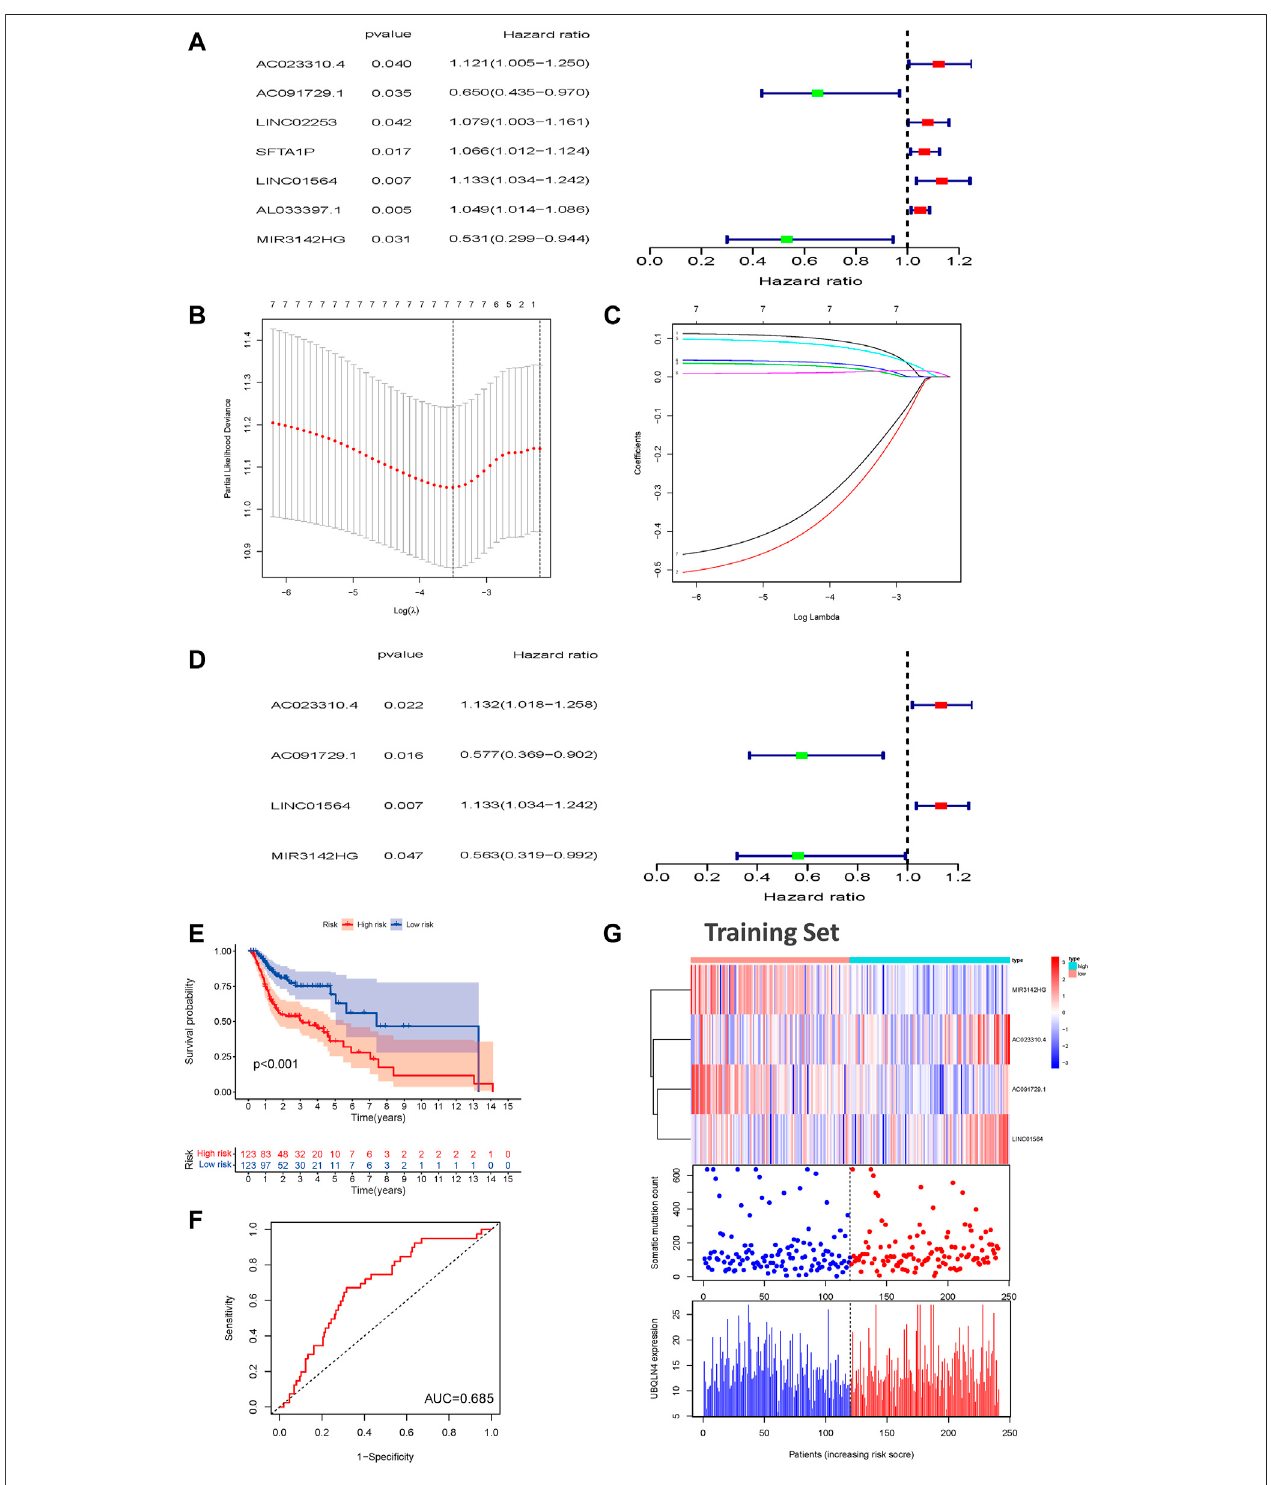
FIGURE 3 | Construction of a prognostic model related to overall survival of HNSCC patients based on genome instability-related lncRNAs in the training set. (A) Seven prognostic relevant lncRNAs based on univariate Cox regression analysis. (B) Screening the Log Lambda value corresponding to the minimum cross-validation error point. (C) The distribution plot of the LASSO coef fi cient. Selecting genome instability-related lncRNAs with a non-zero coef fi cient corresponding to the same Log